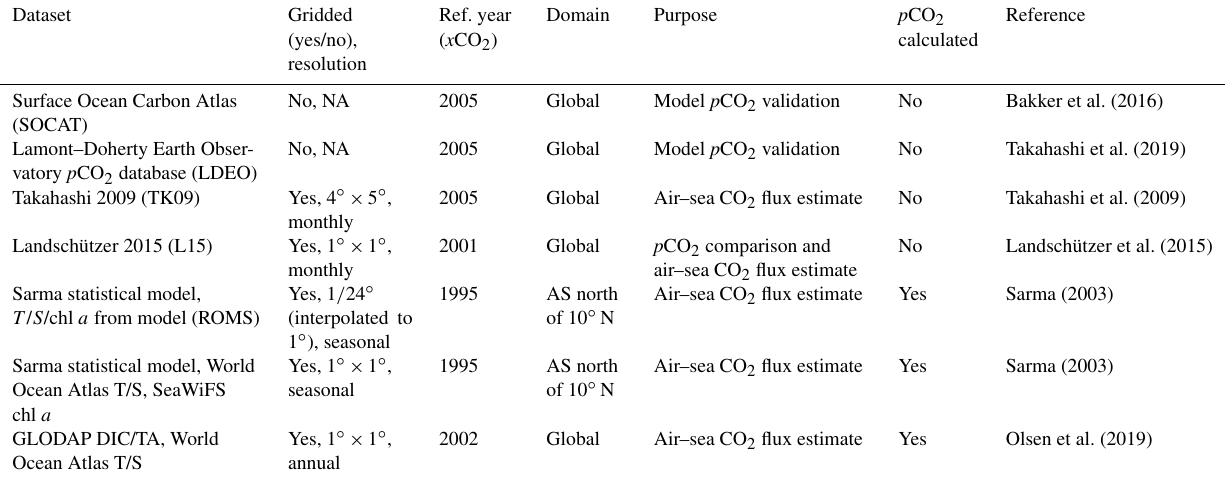
Table 1. Summary of p CO 2 datasets used in this study. Included is whether the product is gridded and, if so, its spatial and temporal resolution. Reference year (Ref. year) indicates the year from which Keeling atmospheric x CO 2 values are used to calculate CO 2 flux. Purpose designates use case within the article. p CO 2 calculated indicates whether product provides p CO 2 (no) or whether p CO 2 was calculated using DIC, TA, temperature, salinity, and possibly chl a (yes).